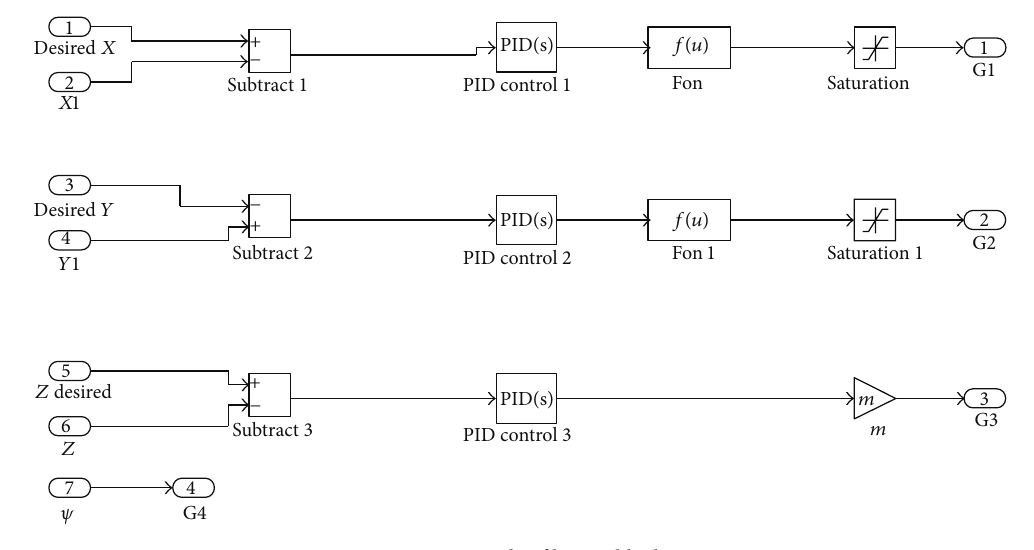
Figure 10: Inside of layer 3